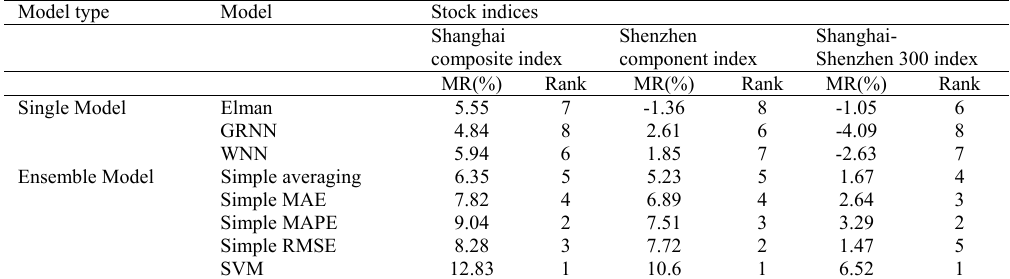
Table 6. Comparison of performance of MR averaging each model over 20 runs.